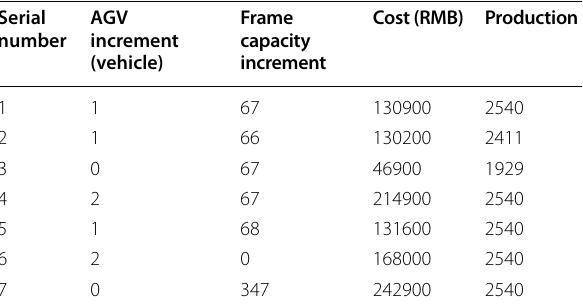
Table 4 Comparison table of optimization